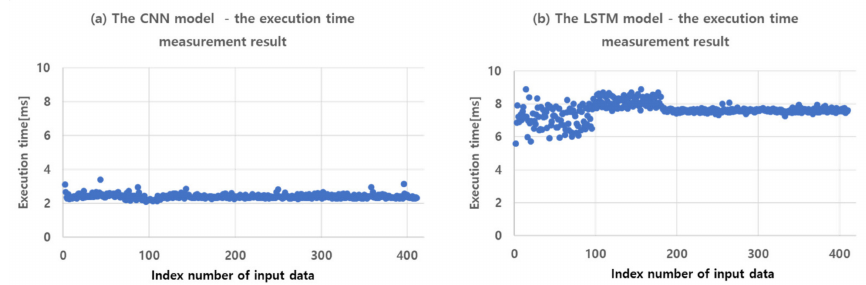
Figure 12. Real-time execution time